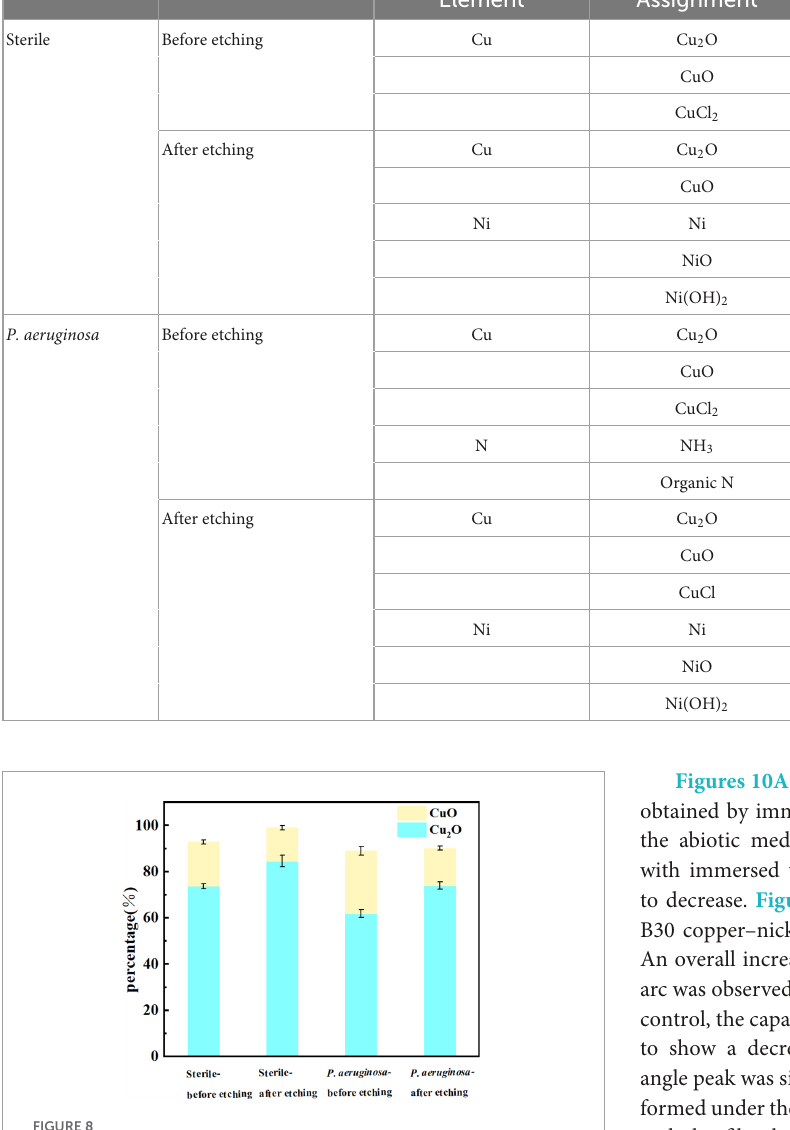
FIGURE8 Cu oxide content on the surface of B30 copper–nickel alloy after 21 days of immersion in different